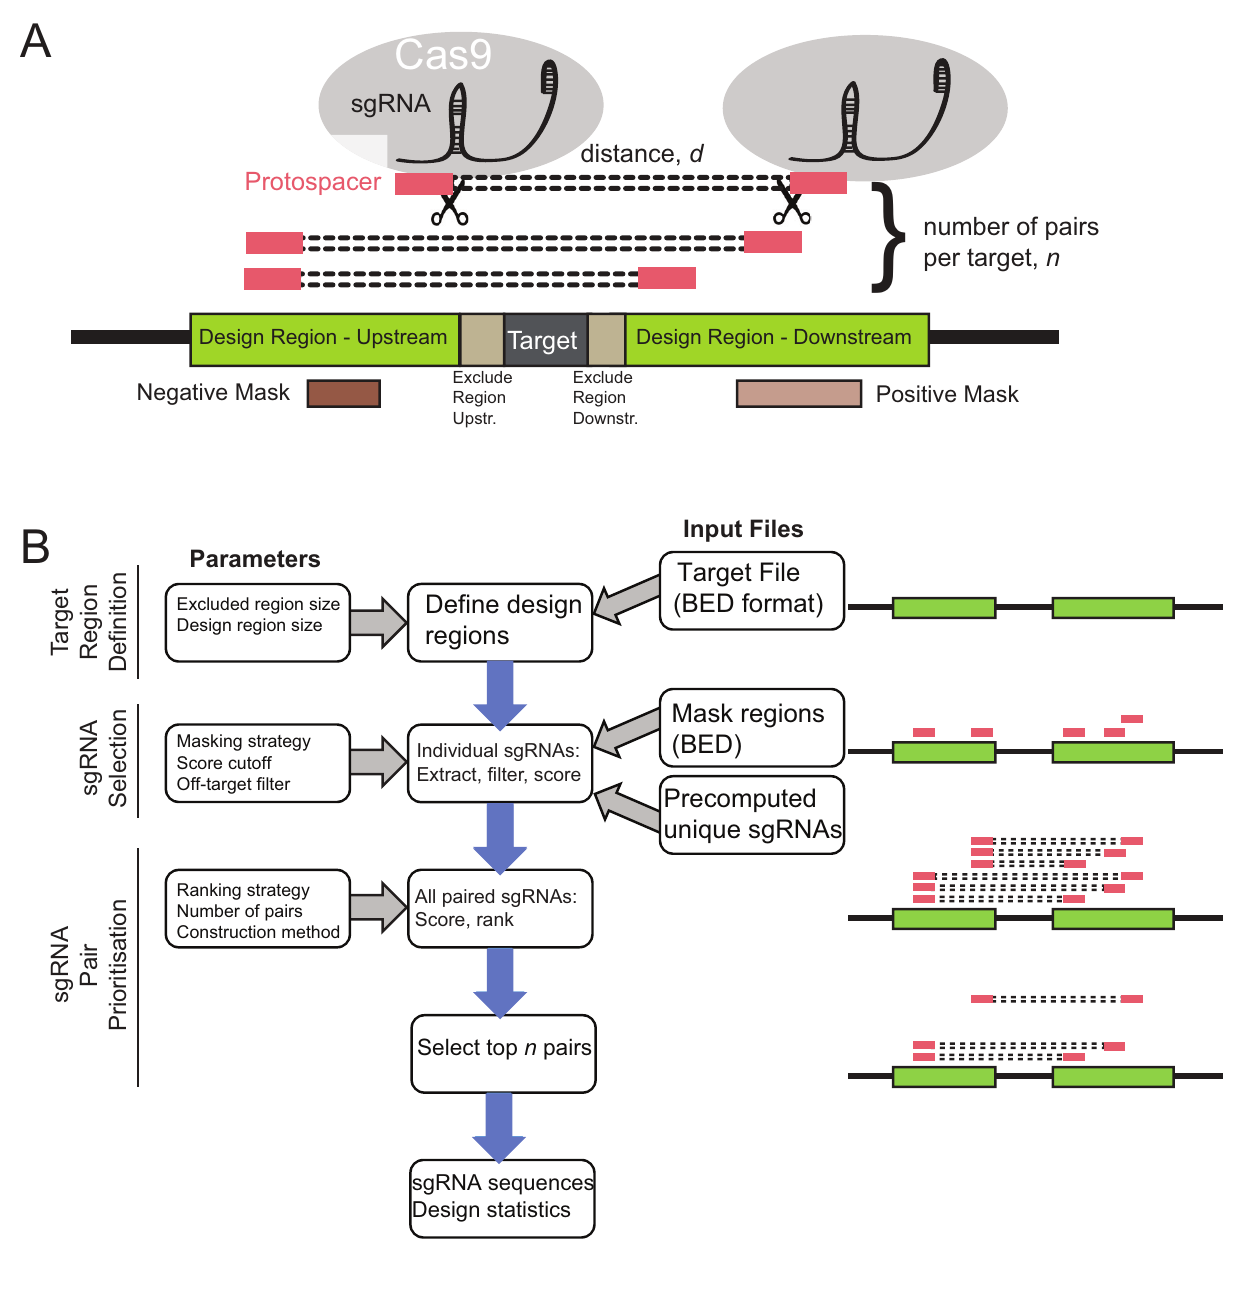
Fig 1. Overviewof CRISPETa pipeline. (A) Schematic of CRISPR-mediatedgenomicdeletion.The aim is elimination of the Target region through recruitment of a pair of Cas9 proteins. Red boxes represent protospacers, the 20 bp upstream of a PAM and recognised by the sgRNA. (B) The CRISPETa